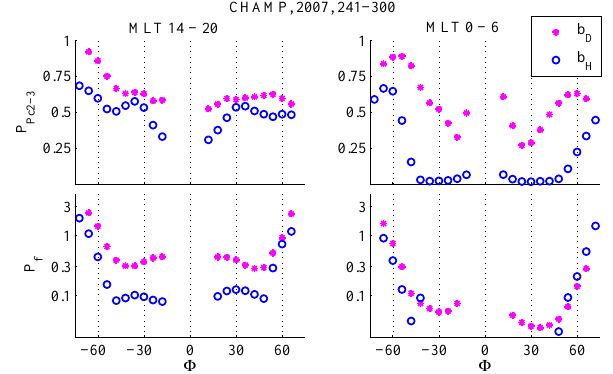
Figure 8. Latitude distribution of the occurrence rate (upper panel)and PSD (bottom panel) for CHAMP Pc2-3 in two MLT sec- tors over 2 months in 2007. Two components are given by different markers and colors.